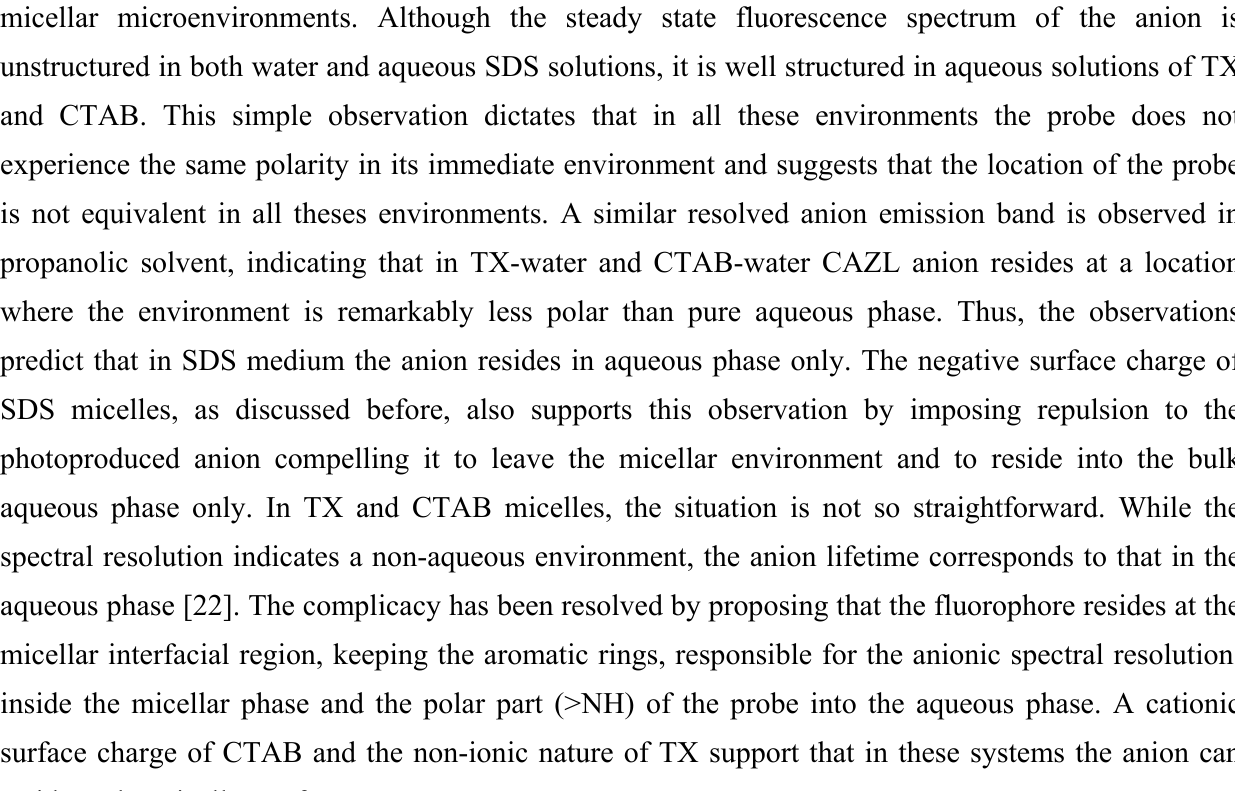
of CAZL vs. 14 + log 0